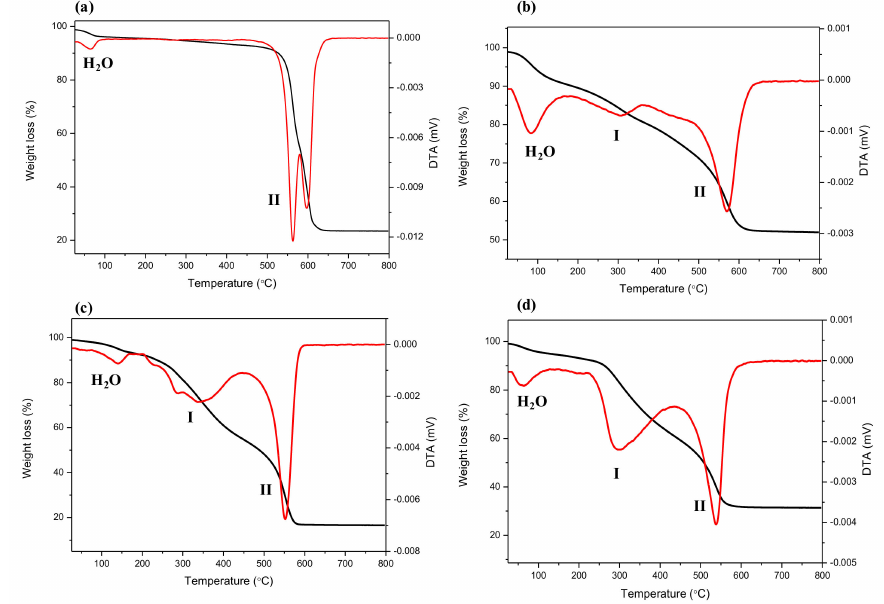
Figure 3. Thermogravimetric (TG) and derivative (DTA) curves: ( a ) MIL-53(Al), ( b ) Al-ITQ-EB, ( c ) Al-ITQ-HB and ( d )